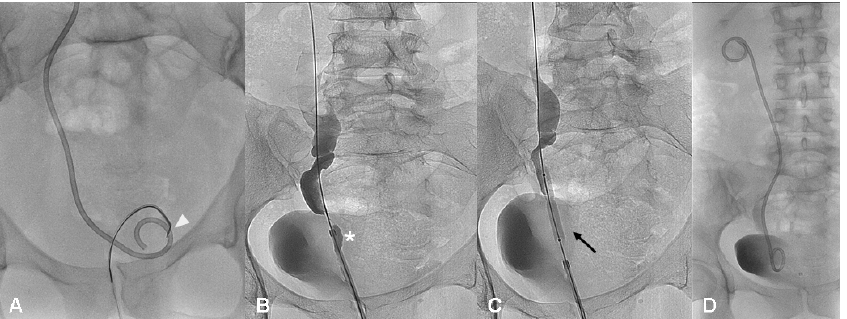
Figure 3. ( A – D )—Double J stent substitution and ureteral ballooning. The distal end of the right ureteral double J stent is grasped with a goose-neck snare catheter (white arrow head) positioned in the lumen of the opacified bladder under fluoroscopic guidance ( A ); ascending pyelography through a vascular 7 Fr introducer shows a residual stenosis (white asterisk) at the distal portion of the right ureter ( B ); ureteral dilatation procedure is performed using 6 × 40 mm balloon (black harrow) ( C ); a new double-J stent was inserted and correctly positioned ( D